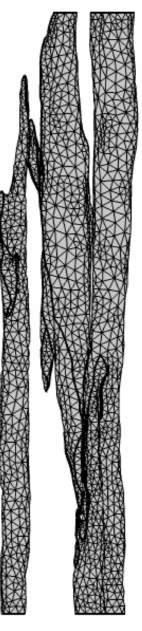
Figure 5. Mesh generation of connected